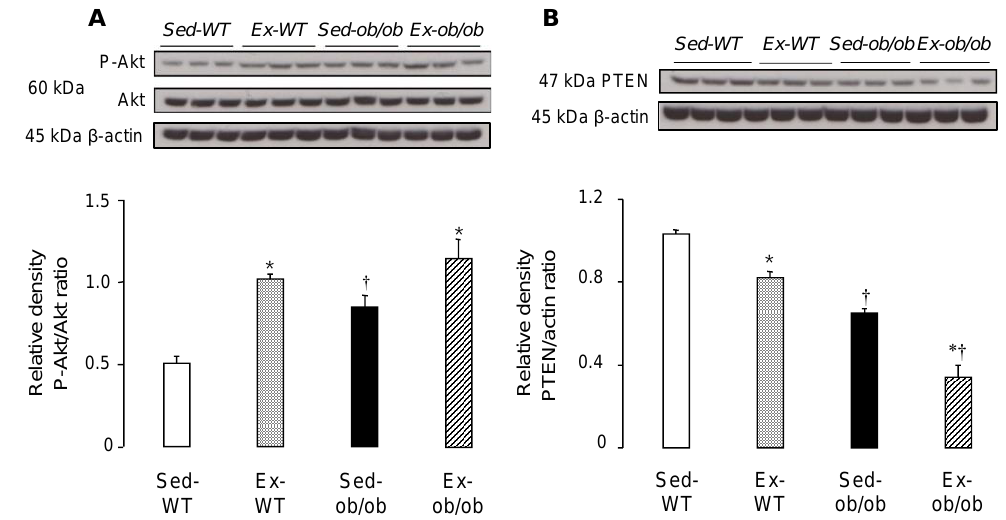
Figure 1. Western blot analysis of Akt and its phosphorylated form (Panel ( A )), as well as the corresponding phosphatase PTEN (Panel ( B )), in cytosol in sedentary conditions (Sed) or after